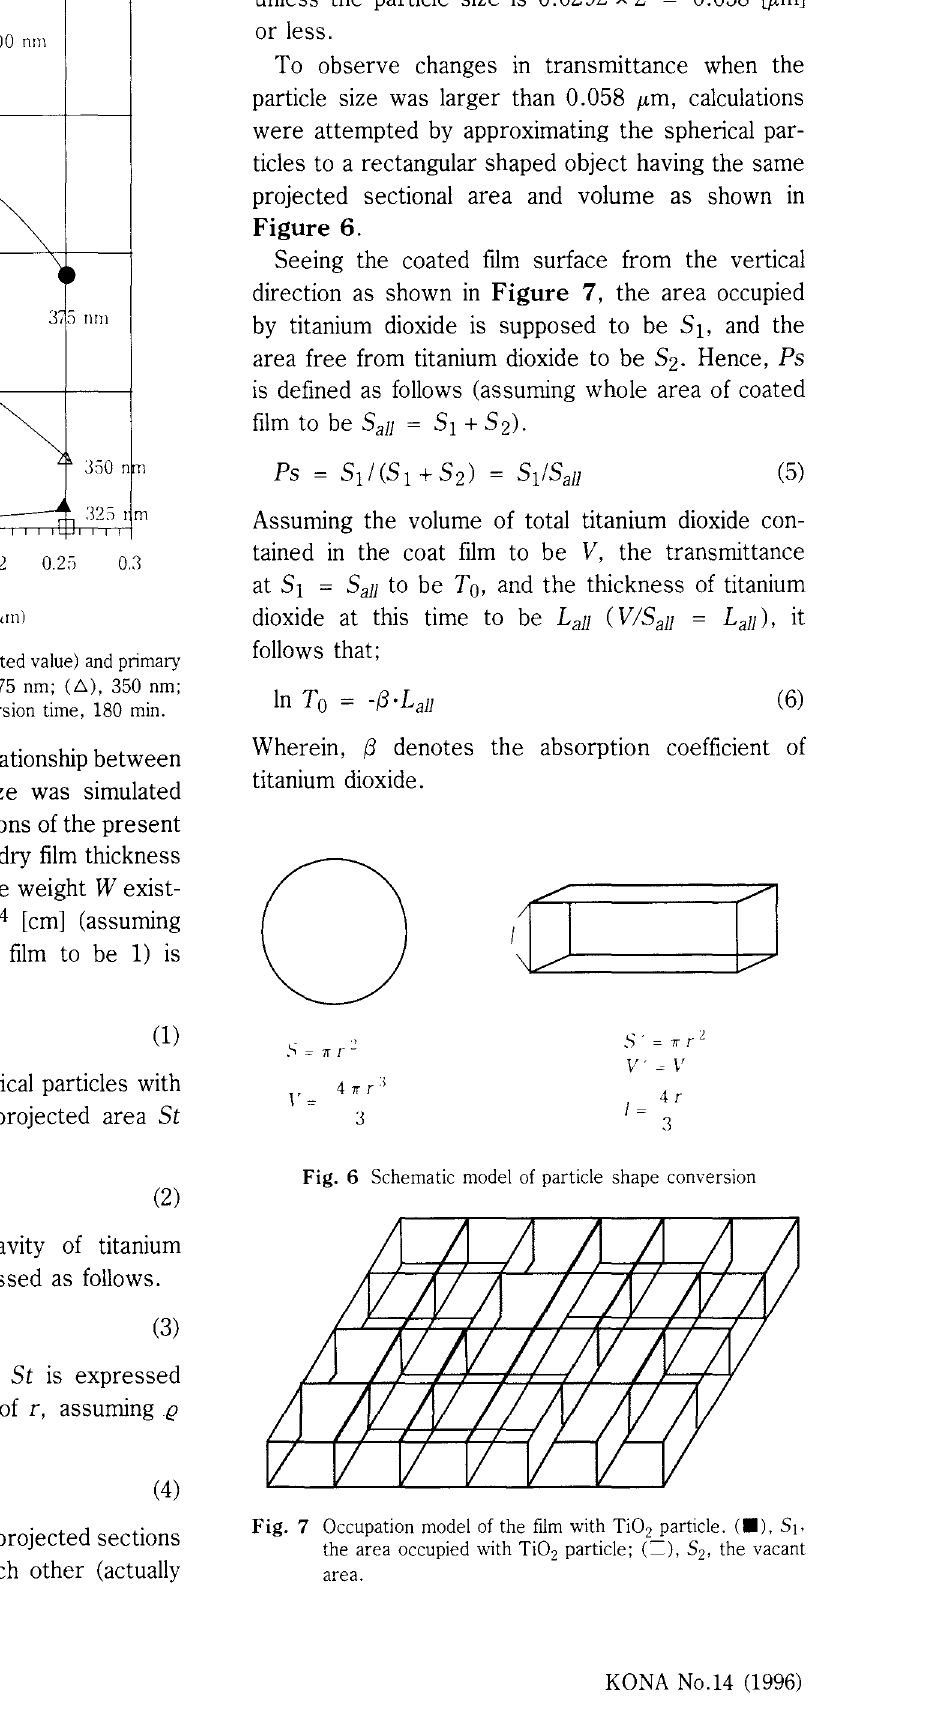
Fig. 7 Occupation model of the film with Ti0 2 particle. (.). S1. the area occupied with Ti0 2 particle; (=).5 2, the vacant